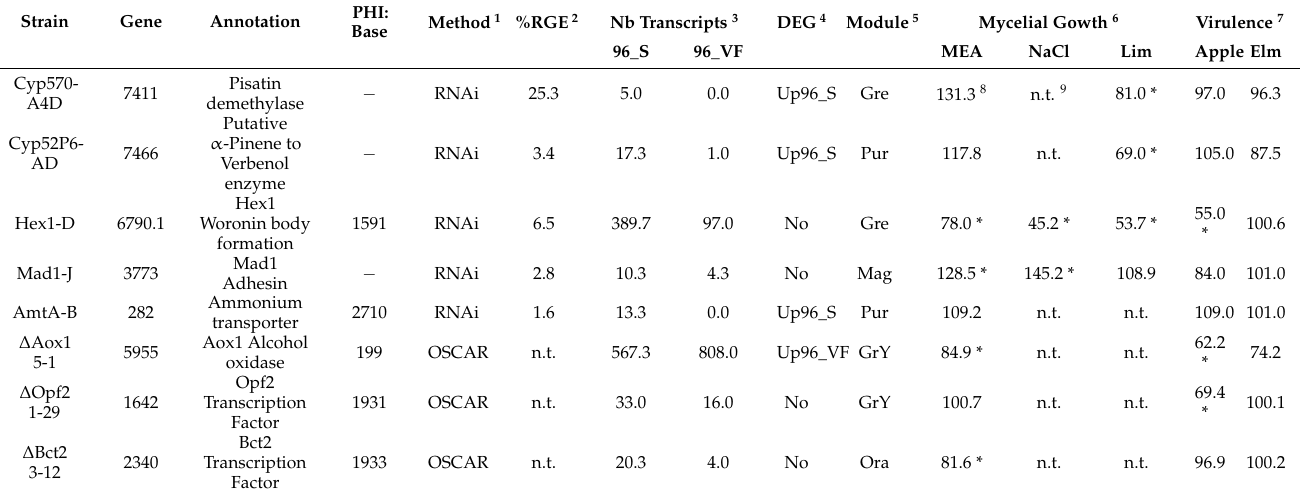
Table 3. Phenotypes of knockdown- and knockout mutants of Ophiostoma novo-ulmi in vitro and in